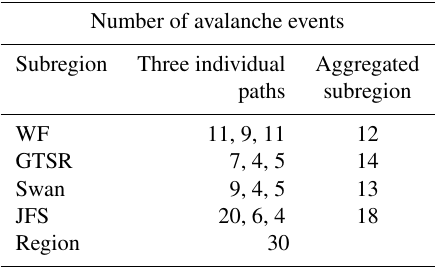
Table 5. Number of avalanche events for each subregion, the mean of three individual paths in each region, and the overall aggregated